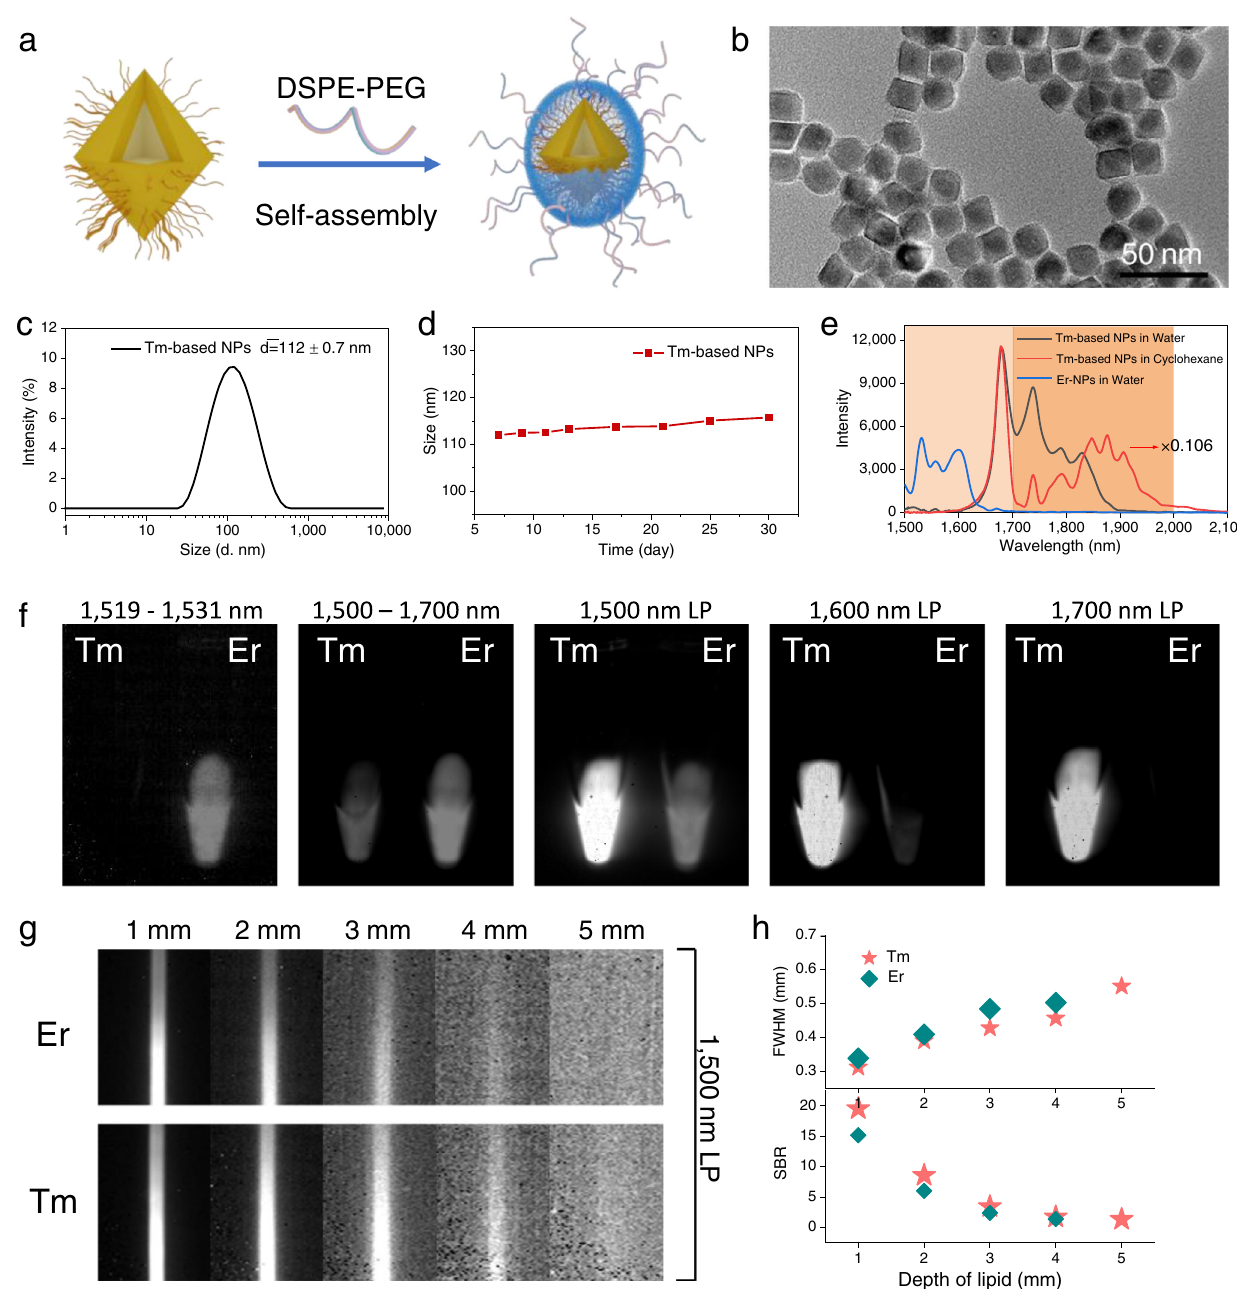
Fig. 3 | Biocompatibilitymodi fi cation ofthe Tm-based NPs. a PEGylation ofTm- based NPs via hydrophobic-hydrophobic interactions between DSPE-PEG and OA- capped Tm(02Er)-NPs. Their corresponding b TEM image c DLS spectrum after PEGylation and d stability of PEGylation Tm-based NPs monitored by DLS. e DSL spectra of OA-capped Tm(02Er)-NPs in cyclohexane, Tm(02Er)-NPs@PEG and Er- NPs@PEG in water upon excitation at 800nm. f Tm(02Er)-NPs@PEG and Er- NPs@PEG nanoparticles in vitro under 800nm excitation (50mW/cm 2 ) with